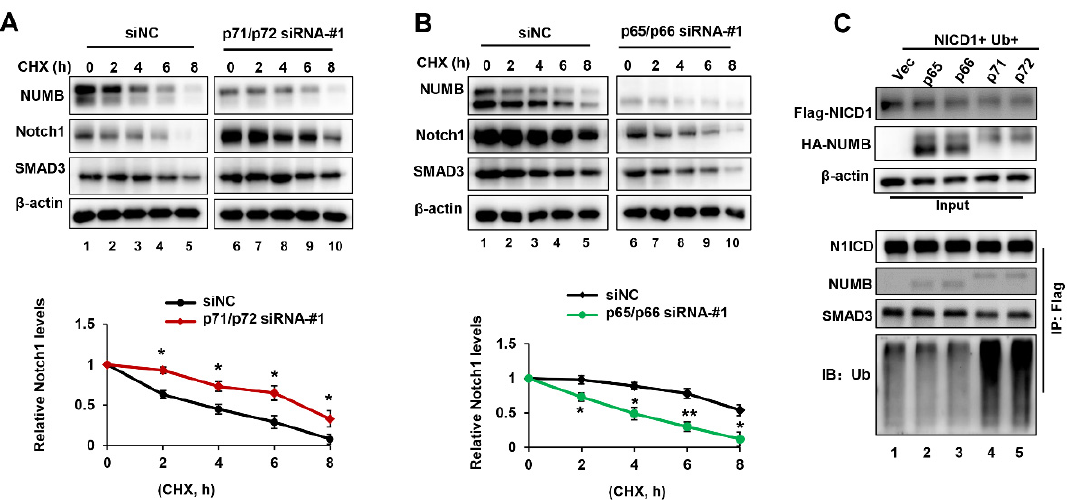
Figure 5. NUMB p71/p72 isoforms promoted ubiquitylation of N1ICD and its degradation. ( A ) RKO cells were transiently transfected with si-p71/72-#1 for 48 h, then incubated in the presence of cycloheximide (CHX, 50 μ g/mL) for the indicated time course, followed by Western blotting analysis. Quantification of Notch1 proteins is shown at the bottom. ( B ) HeLa cells were transiently transfected with si-p65/p66-#1 for 48 h, then incubated in the presence of cycloheximide (CHX, 50 μ g/mL) for the indicated time course, followed by Western blotting analysis. Quantification of Notch1 proteins is shown on the bottom. ( C ) 293T cells were co-transfected with Flag-N1ICD, Ubiquitin (Ub) and NUMB isoform expression plasmids. Whole-cell lysates were extracted and immunoprecipitated with anti-Flag antibodies followed by Western blotting analysis. Overall, 10% of whole cell lysates were used as input. * p < 0.05, ** p < 0.01.